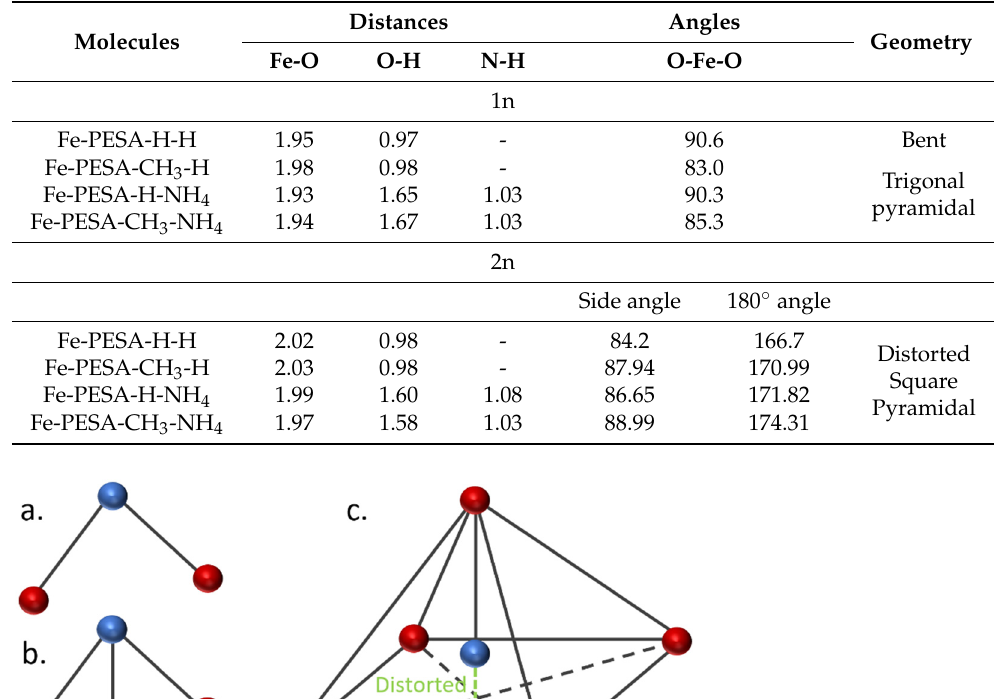
Table 1. Geometrical analysis of the optimized molecular structure of Fe-PESA complexes, including the distances and angles.